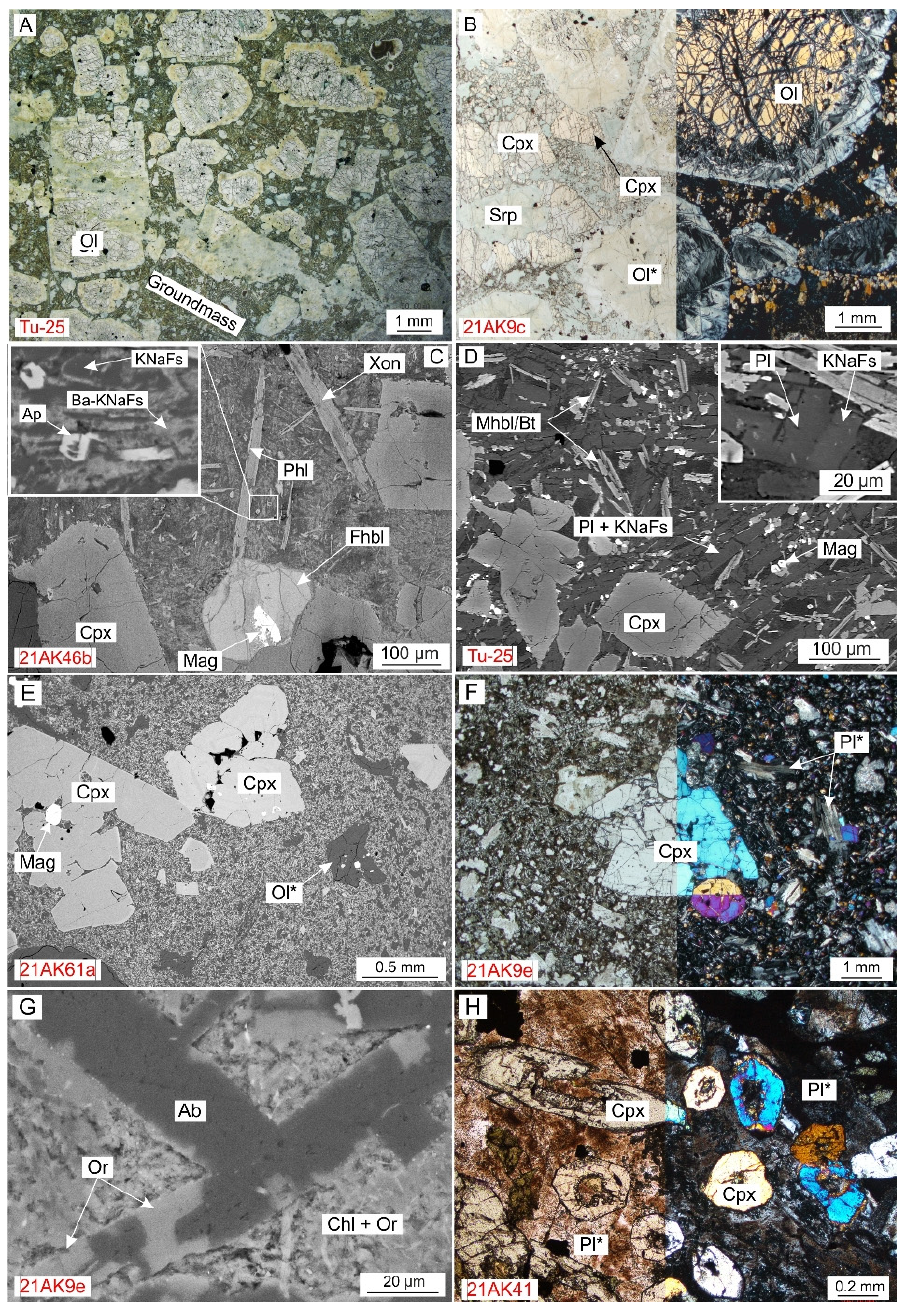
Figure 4. Petrographical features of the volcanic rocks. ( A ) picrite (transmitted light photo); ( B ) olivine phenocrysts and groundmass clinopyroxene in picrite (transmitted light photo, left side—analyzer out, right—analyzer in); ( C ) groundmass in picrite (BSE-photo), on the inset—close-scale of the cryptocrystalline aggregate; ( D ) groundmass in picrite with abundant feldspars (BSE-photo), on the inset—close scale of a zoned feldspar grain; ( E ) phenocrysts of clinopyroxene and pseudomorphs of serpentine after olivine phenocrysts in basalt (BSE-photo); ( F ) clinopyxoxene and plagioclase phenocrysts in basalt (transmitted light photo, left side—analyzer out, right side—analyzer in); ( G ) patchy replacement of groundmass feldspar in basalt by albite and orthoclase in a cryptocrys- talline aggregate of chlorite and orthoclase (BSE-photo); ( H ) holocrystalline basalt with rodlike boxy clinopyroxene (transmitted light photo, left side—analyzer out, right side—analyzer in). Hereinafter mineral abbreviations are after [71], in addition, Ba-KNaFs is Ba-rich alkali feldspar. An asterisk (*) after the mineral symbol means that the mineral has been extensively altered or